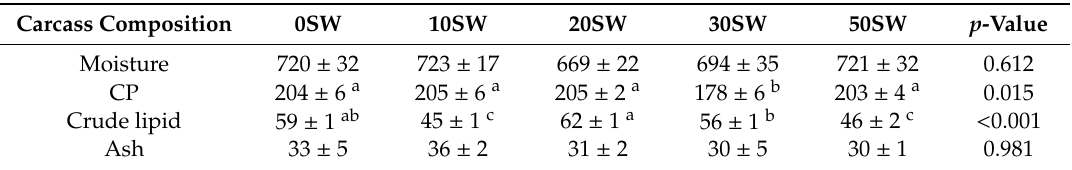
Table 5. Carcass proximate composition (g kg − 1 wet weight) of the sex-reversed Nile tilapia fed experimental diets containing various replacement levels of FM protein by